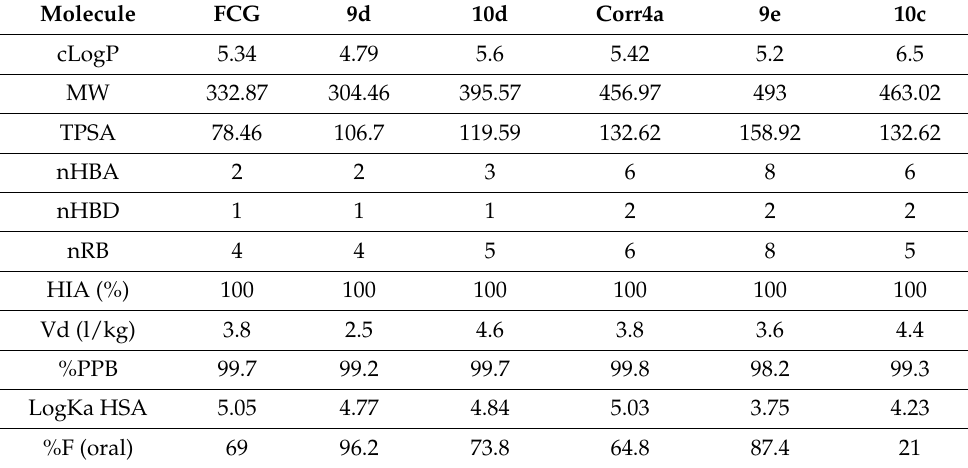
Table 1. Calculated ADME descriptors related to absorption and distribution properties of FGC, corr 4a and their